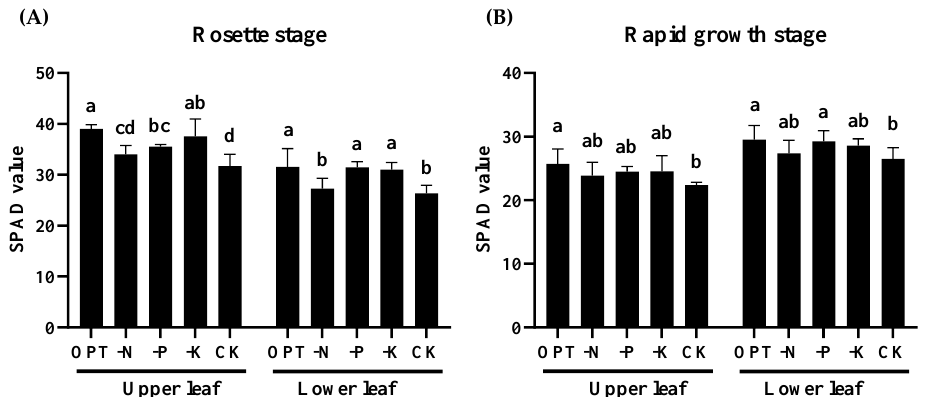
Figure 4. Effects of N, P, and K balanced fertilization on SPAD values of different leaves at two growth stages of lettuce. SPAD values of the upper and lower leaves were measured at both rosette stage ( A ) and rapid growth stage ( B ). Different letters indicate the distinct differences at p < 0.05. Without fertilization, lettuce yield was significantly reduced (Figure 5A). The lettuce yield decreased by 17.26%, 28.99%, 10.00%, and 40.29%, respectively, when compared with the OPT condition. When compared with other treatments, OPT significantly im-